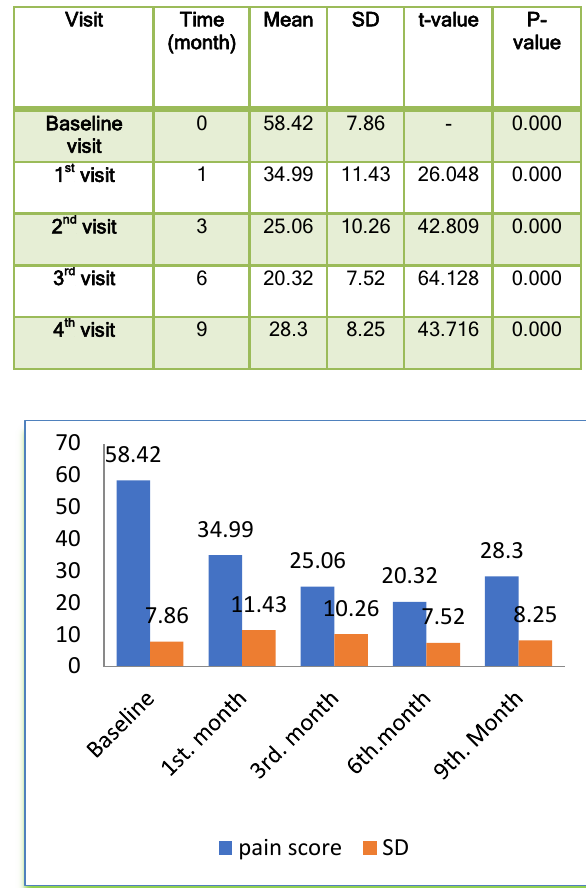
Figure 11: VAS results with the corresponding visit. Table.3: Stiffness scores results with the corresponding